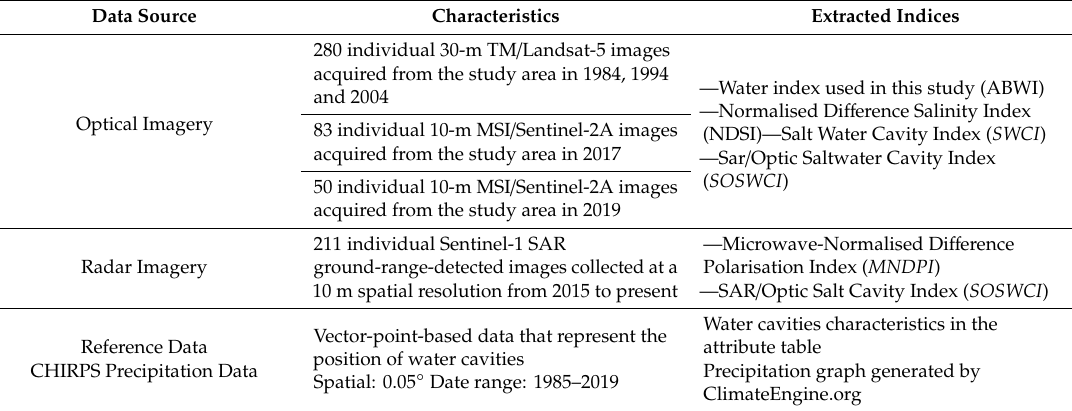
Table 2. Datasets used in this study and the spectral and polarimetric indices extracted from these